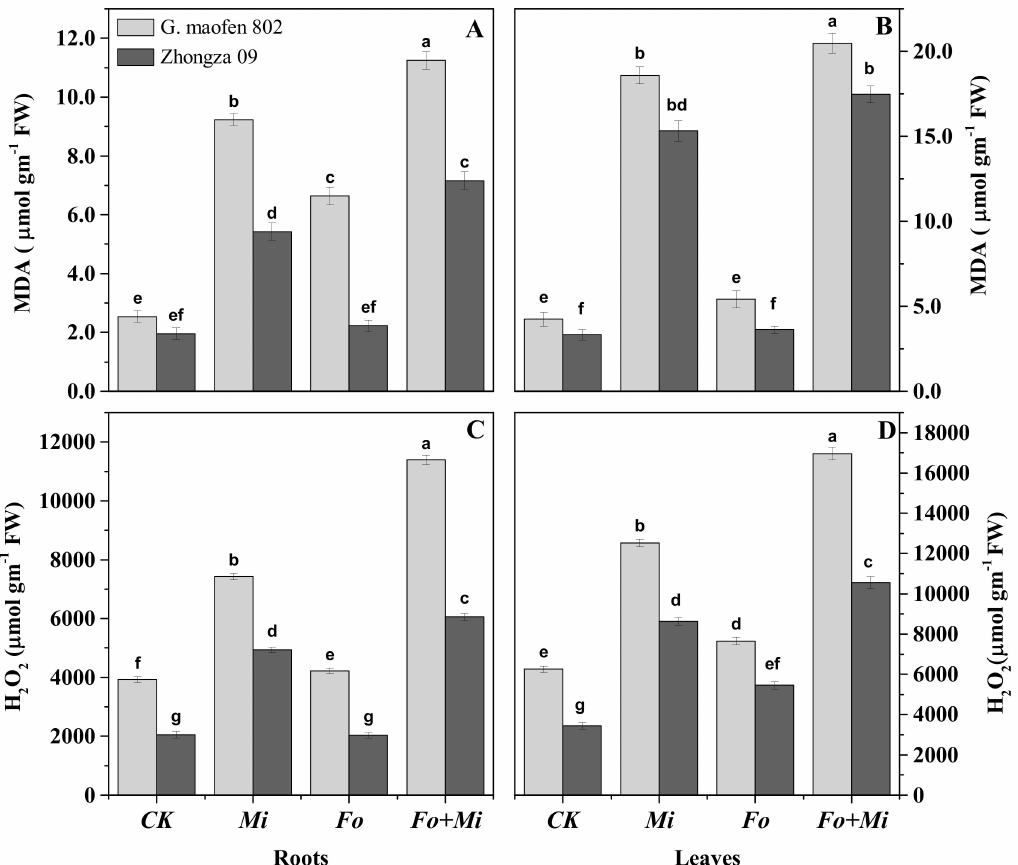
Figure 4. E ff ects of Fusarium oxysporum and Meloidogyne incognita alone and in combination on oxidative stress responses of two tomato cultivars (G. maofen 802 and Zhongza 09) under greenhouse conditions at 14 DAI.: ( A ) malondialdehyde (MDA) contents in roots, ( B ) malondialdehyde (MDA) contents in leaves, ( C ) hydrogen peroxide (H 2 O 2 ) contents in roots, and ( D ) hydrogen peroxide (H 2 O 2 ) contents in leaves. Bars showing dissimilar lower-case letters are statistically di ff erent from each other at p ≤ 0.05 (Tukey–Kramer test). Values are mean ±